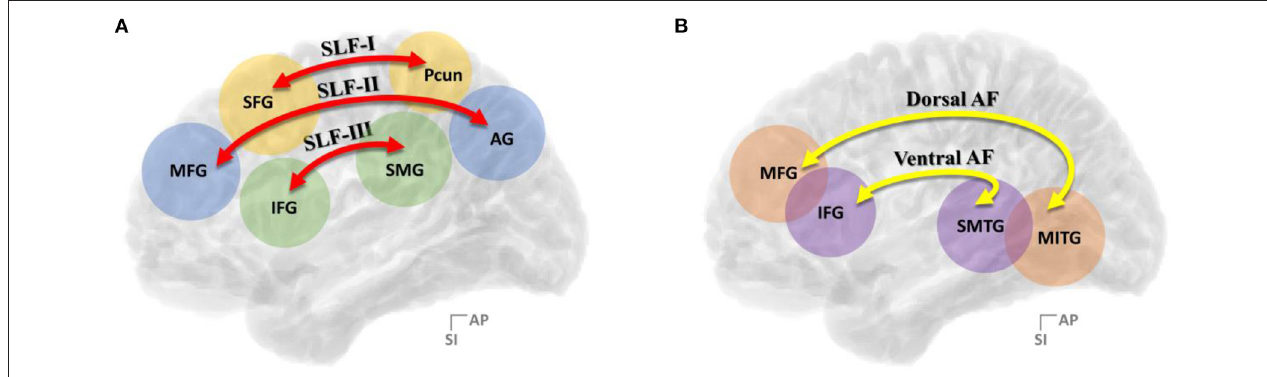
FIGURE 1 | Summary of the (A) three-segment model of SLF connectivity and the (B) two-segment model of AF connectivity. SLF, superior longitudinal fasciculus; AF, arcuate fasciculus; AG, angular gyrus; IFG, inferior frontal gyrus; MFG, middle frontal gyrus; MITG, middle and inferior temporal gyri; SFG, superior frontal gyrus; Pcun, precuneus; SMG, supramarginal gyrus; SMTG, superior and middle temporal